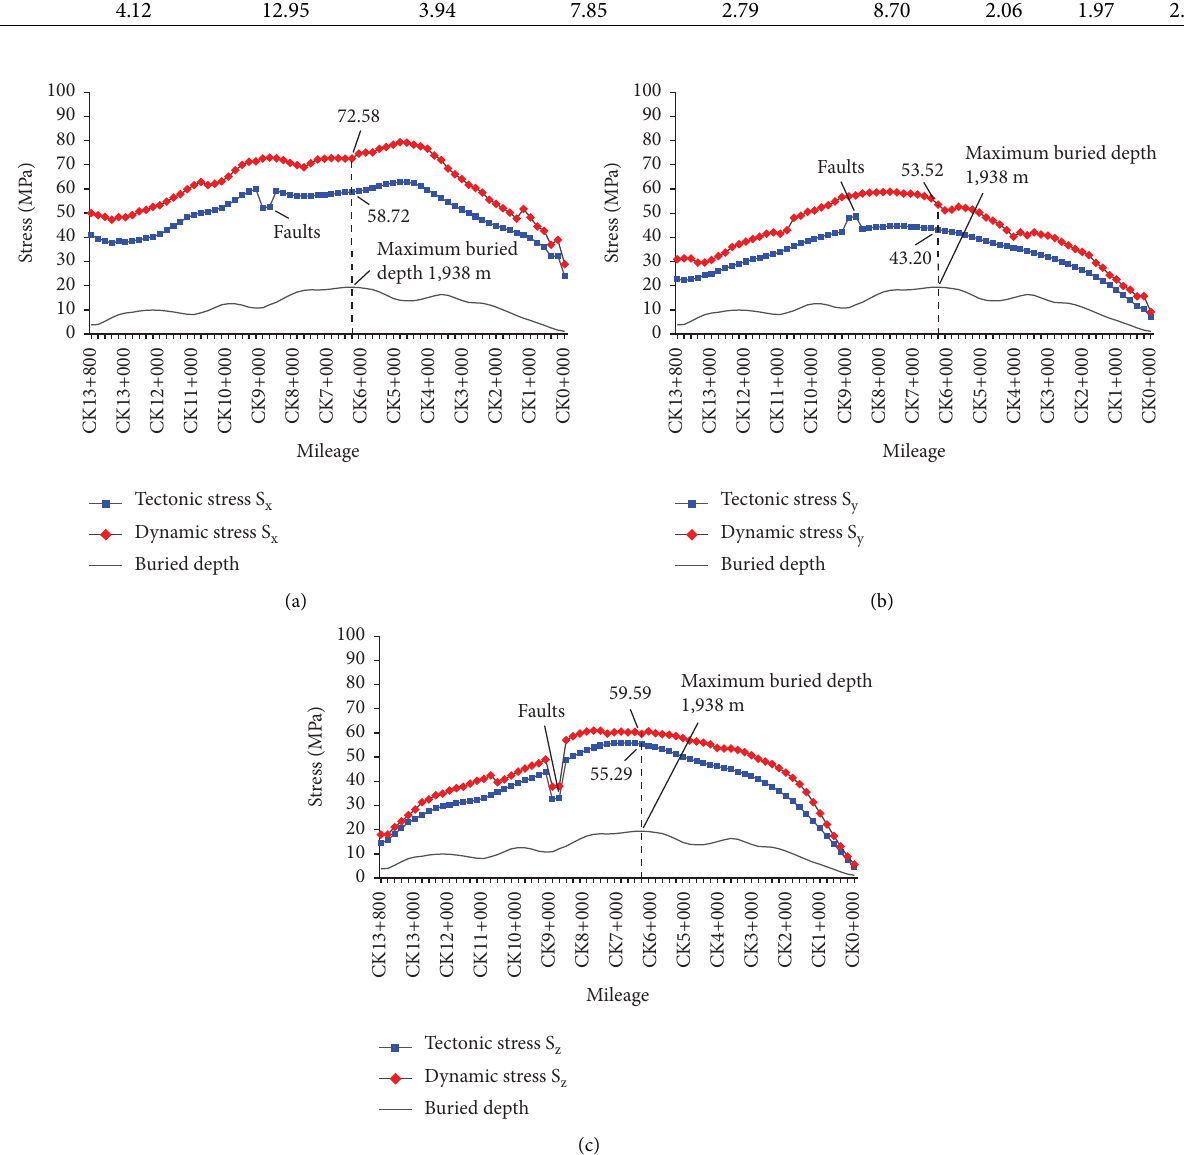
Figure 9: Curve of comparison between dynamic stress and tectonic stress. (a) S